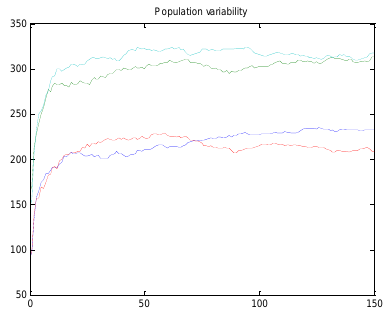
Figure 8. Variance plot to keep track on resembling The differential evolution method is a global optimization technique, so the uniformization can be “dangerous”. If one